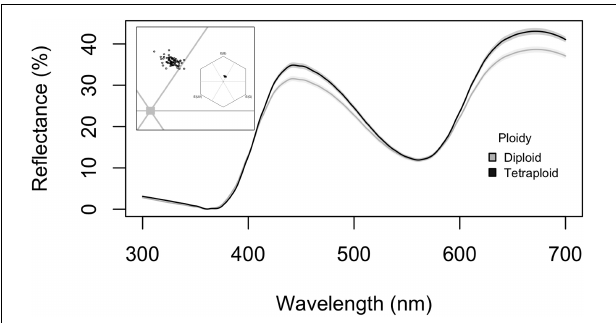
FIGURE 2 | Flower reflectance differences for diploid and tetraploid Chamerion angustifolium plotted from 300 to 700 nm; lines are the treatment mean and shading represents the SE. Inset: flower colour plotted using the colour hexagon for Hymenoptera colour vision to illustrate the overlap of diploid and tetraploid reflectance (empty circles = diploid, filled circles = tetraploid), corners represent blue = E(B), green = E(G), and ultraviolet = E(UV).